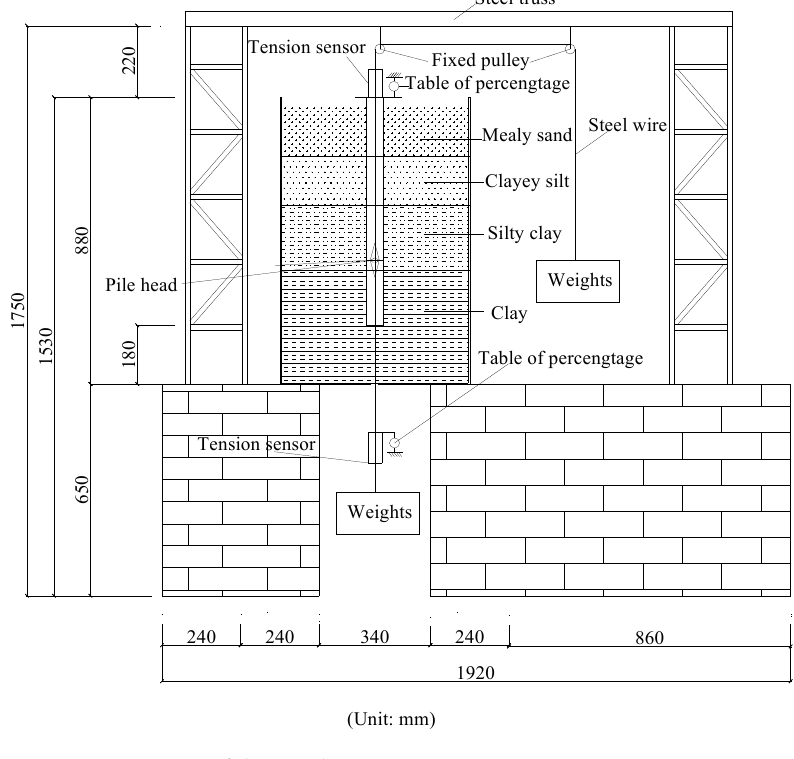
Figure 5. Front view of the test device.